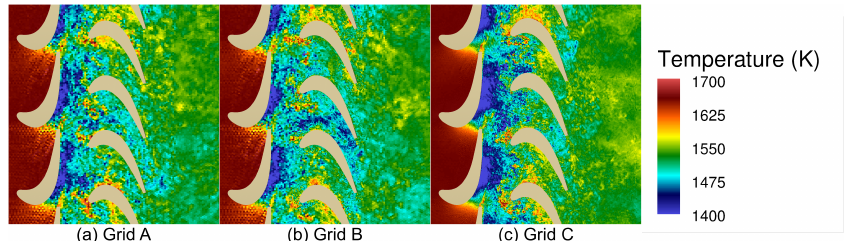
Figure 10. Instantaneous Mach number contours near the stator–rotor region at the location of 50% span of the rotor blade for: ( a ) Grid A; ( b ) grid B; and ( c ) Grid C.